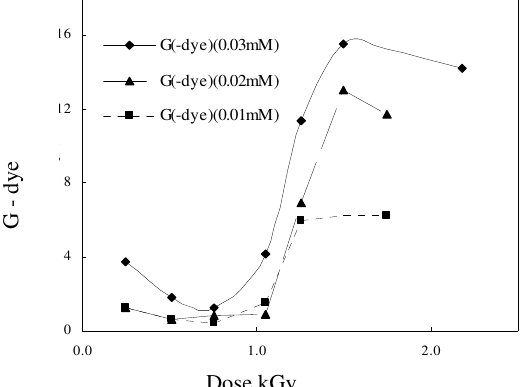
Figure 4. Trend for G–values in the accordance with the dose exposed in 5% methanol